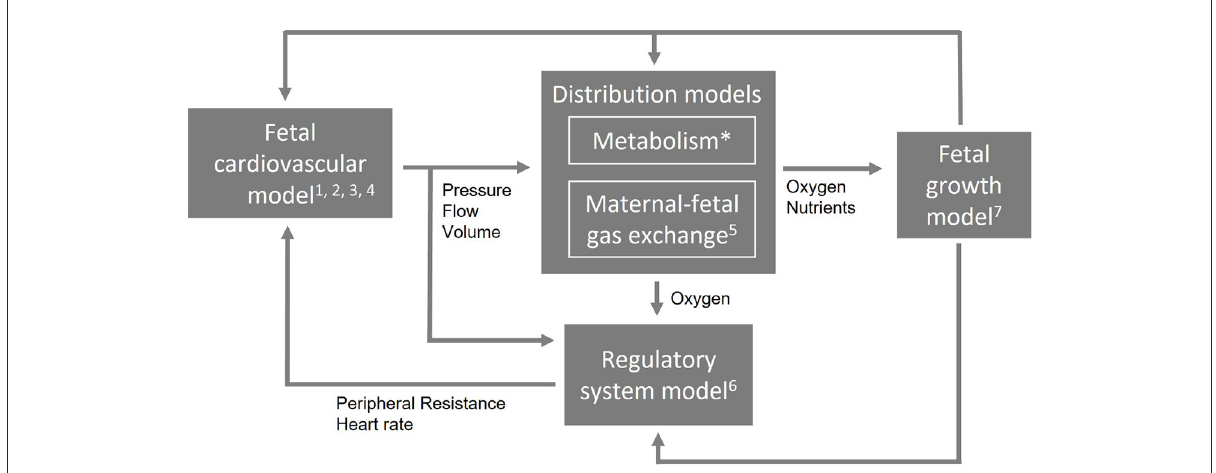
FIGURE1 An example of a modular arrangement. The numbers refer to the numbering of the technical requirements (Section Technical requirements). The first four requirements are applicable to the cardiovascular model. Metabolism is not included in this study (*) and the computational time applies to the entire model (not